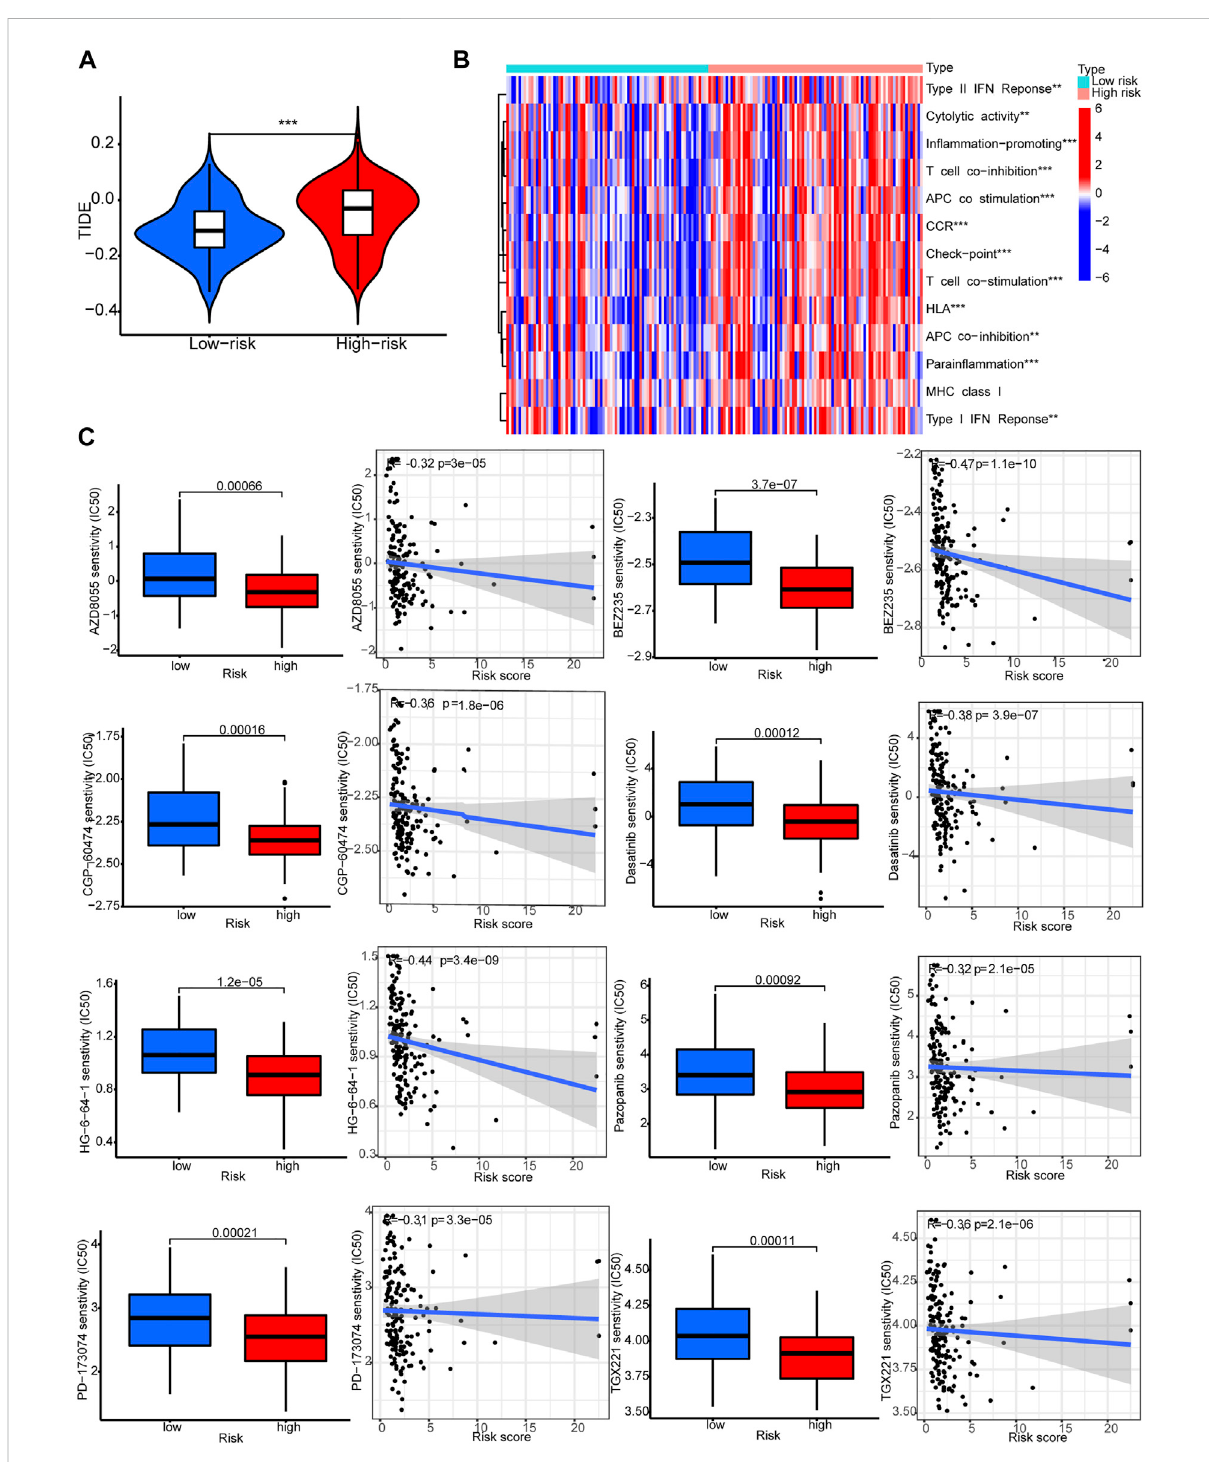
FIGURE 8 Immune functions and prediction of clinical treatment response. (A) TIDE scores. (B) Immune function heat maps. (C) IC 50 of eight